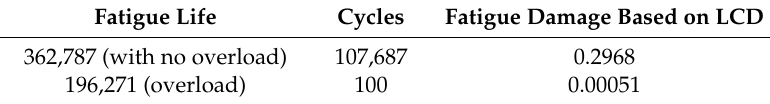
Figure 7. Overload induced on the specimen after detachment of the pressing tool, collected using a strain gauge. Table 2. Fatigue damage at overload, calculated using linear cumulative damage (LCD).